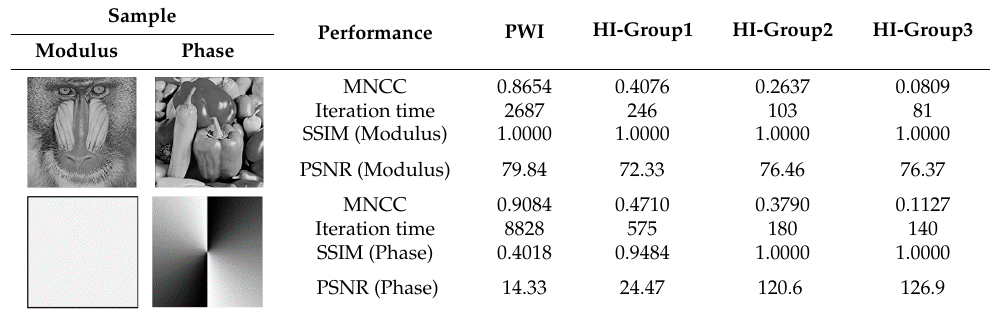
Figure 5. The iteration convergence curve and the reconstructed results under different types of illumination methods. ( a , b ) are the reconstruction results of the amplitude and the phase of object 1, respectively. Table 1. The reconstruction performance under different types of illumination.